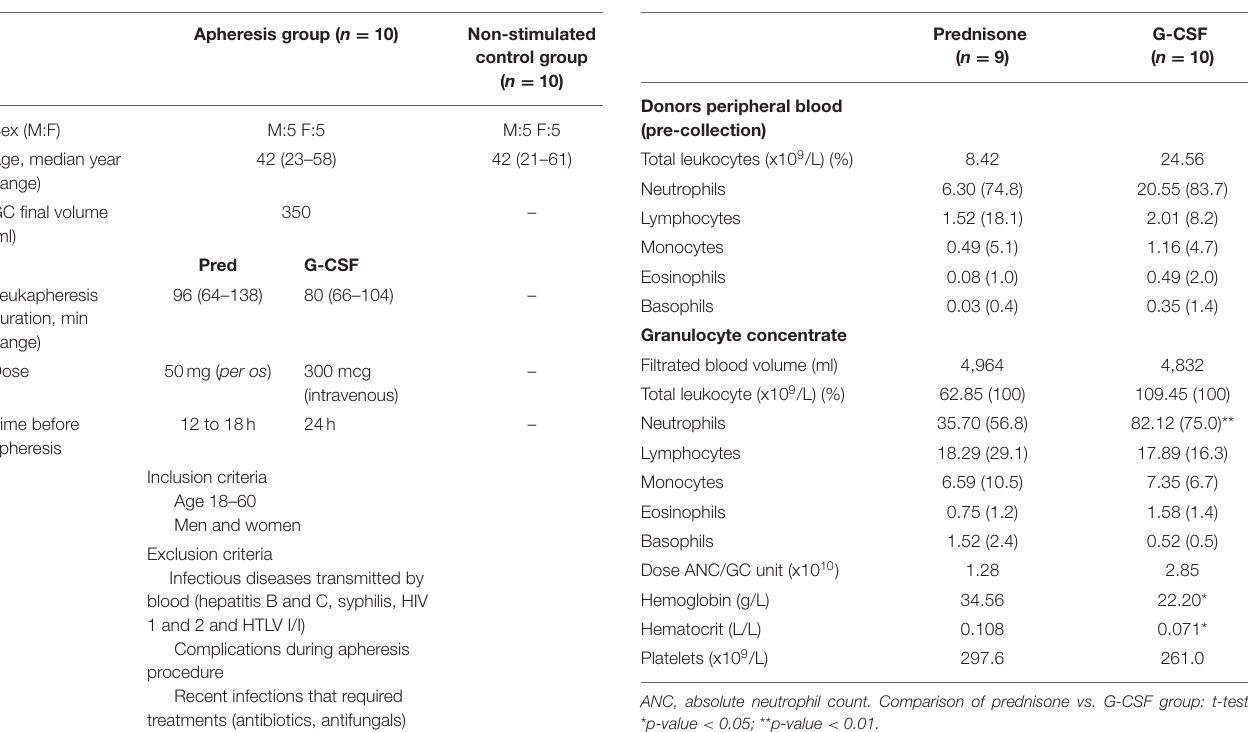
TABLE 1 | Donor characteristics and collection regimens. TABLE 2 | Composition of donor peripheral blood and granulocyte concentrates.